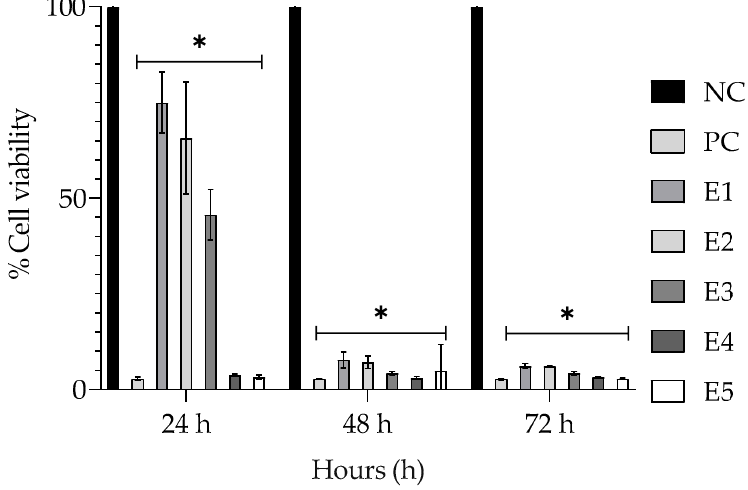
Figure 2. Mean ± SD of the percentage cell viability in the groups treated with the negative control (NC; physiologic solution 0.9%), positive control (PC; 2% Tween 80%), and encapsulated EPPR (E1—31.25 µ g/mL, E2—62.5 µ g/mL, E3—125 µ g/mL, E4—250 µ g/mL, and E5—500 µ g/mL), according to the MTT method. One-way ANOVA followed by Tukey’s post hoc test. The asterisk (*) indicates a significant difference ( p < 0.05) between groups.